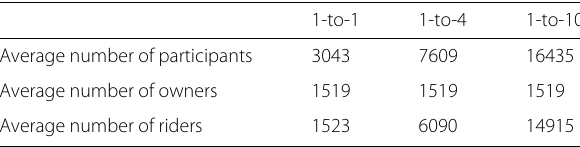
Table 2 Instances with different owner-to-rider